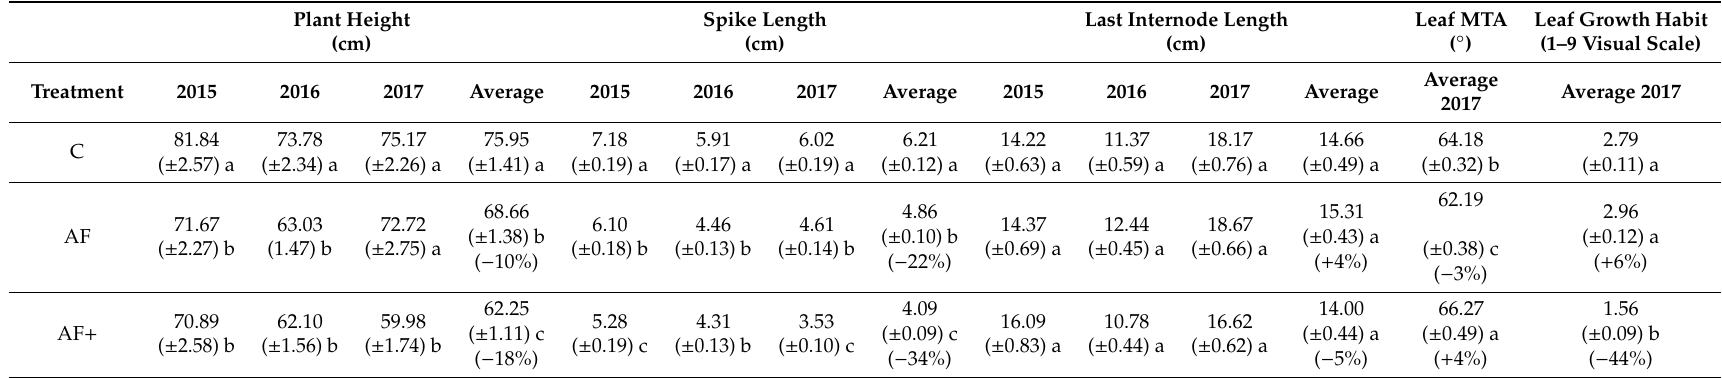
Table 1. Morphological traits of plants grown under the full sun (C), AF, and AF + agroforestry treatments, as an average of all genotypes from 2015–2017 (means). Morphological trait values arose from plant phenotyping at maturity. The average mean tip angle (MTA) and leaf growth habit were recorded only in 2016–2017 and are presented as the average of all the observation dates from the last week of March till the end of